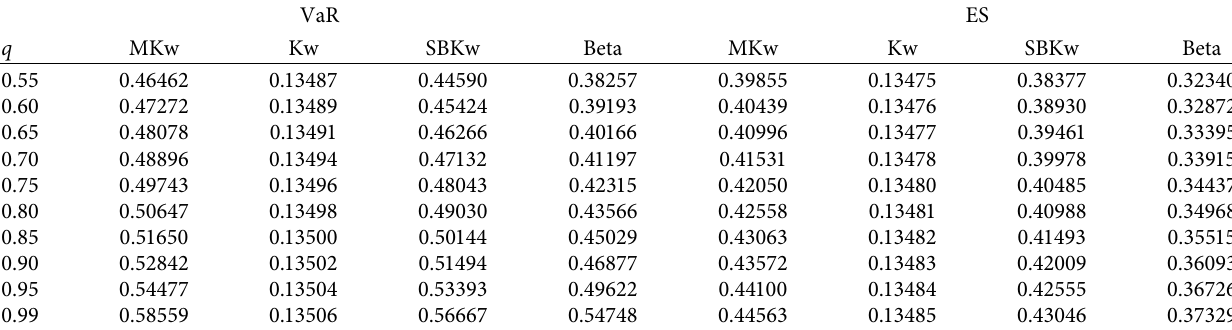
Table 17: Numerical illustration of VaR and ES data set 4.